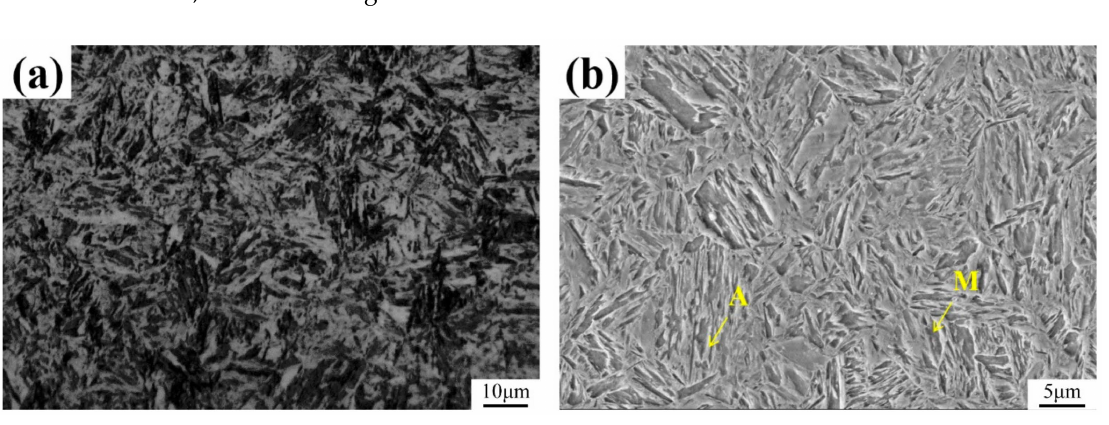
Figure 2. Microstructure of the hot-stamped steel: ( a ) optical microscopy (OM) image and ( b ) scanning electronmicroscopy(SEM)micrograph. Arepresentstheresidualaustenite,